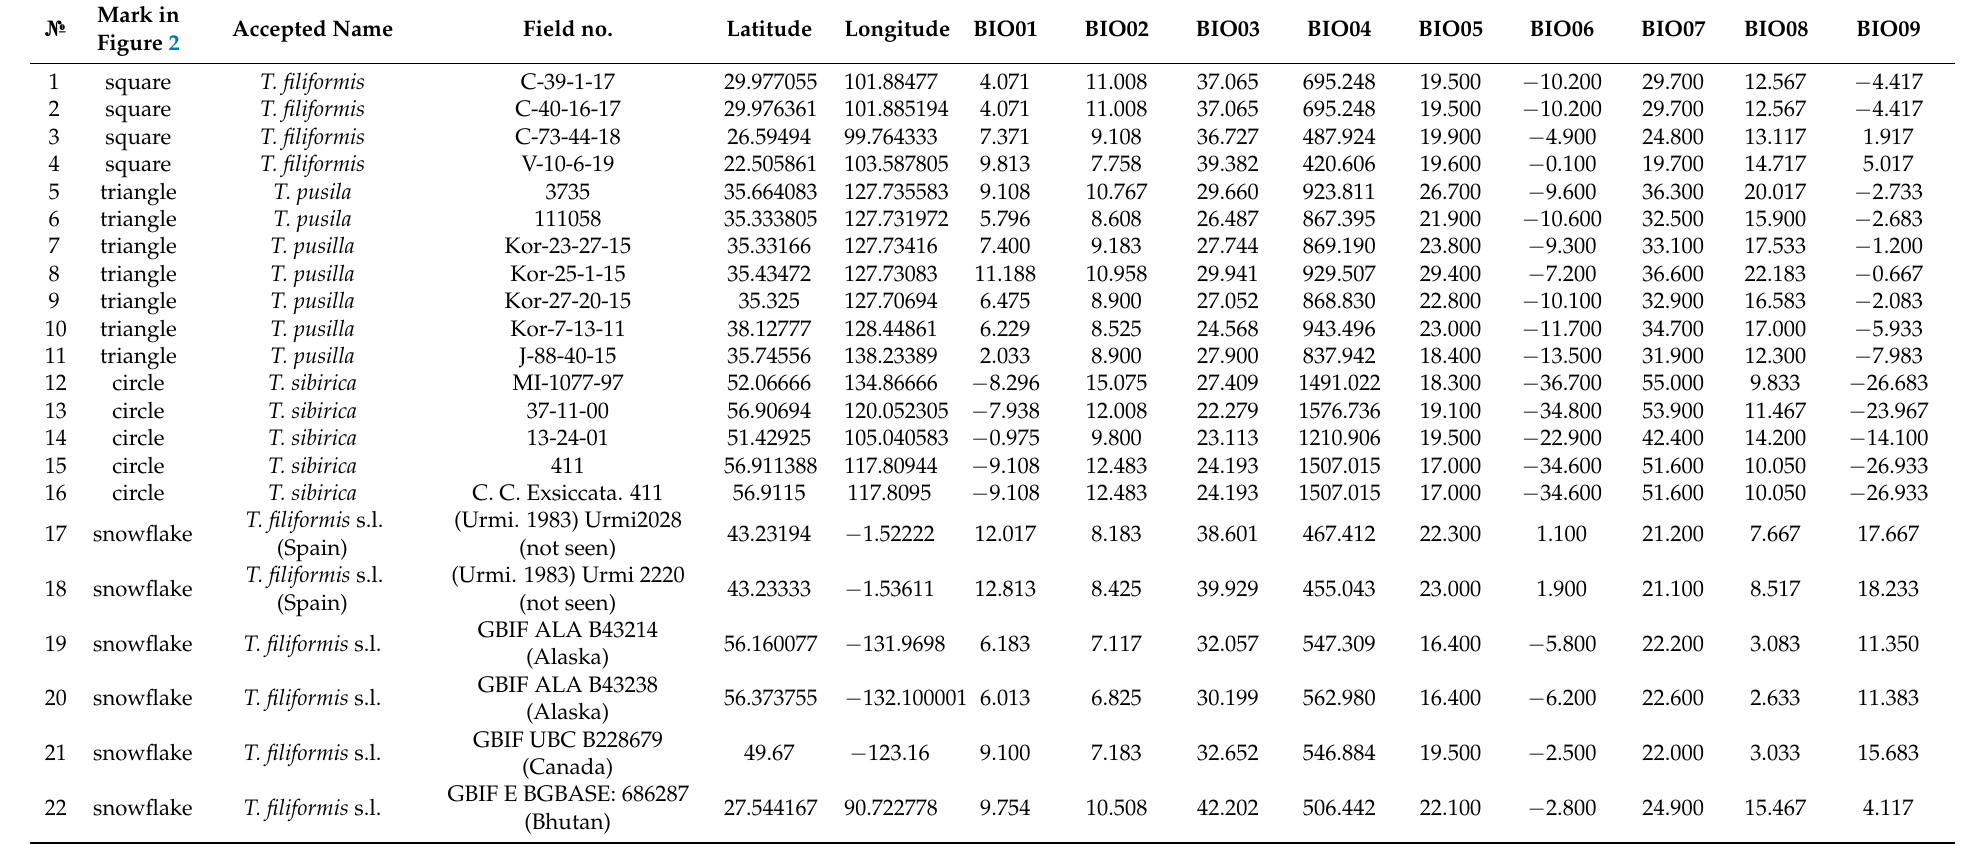
Table 2. The bioclimate indices for each locality where the specimen of Tetralophozia filiformis s.l. was collected (regardless was specimen studied or not)